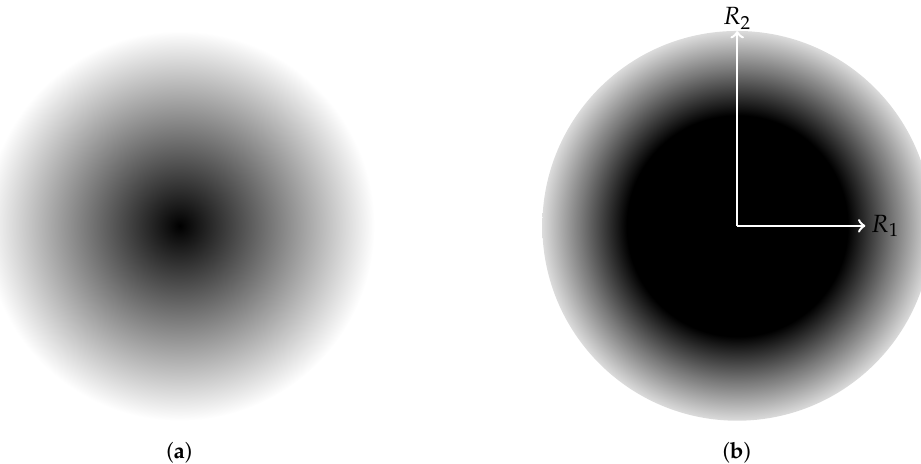
Figure 1. Illustration of ( a ) an attenuated disk model; ( b ) a truncated attenuated disk